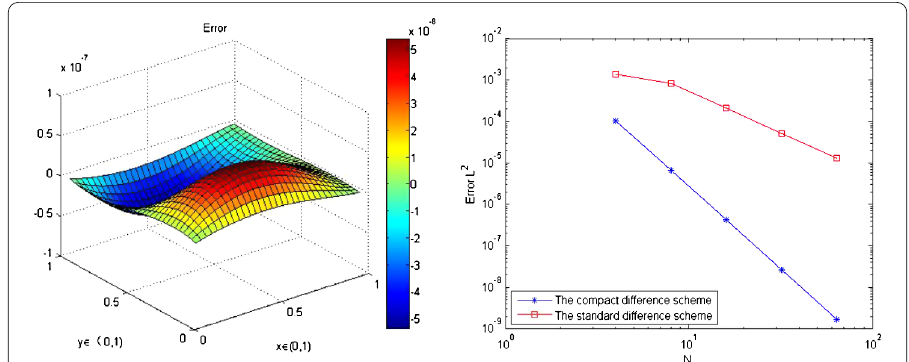
Figure 12 Comparison figures of errors between the standard difference scheme and the compact difference scheme in Example 3. ( a ) Absolute error when T = 1, N = 32 and K = N 2 . ( b ) Approximation order of C in L 2